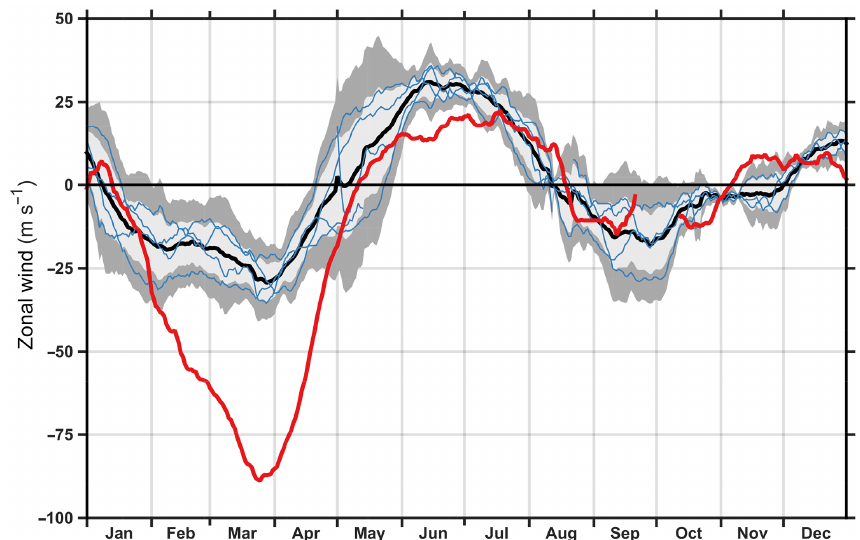
Figure 1. Monthly-mean zonal wind over Ascension Island at a height of 85km altitude during 2002–2007. The thin blue lines are the zonal wind for each of the years 2003–2007, and the mean for this period is shown by the thick black line. The light and dark grey filled areas show 1 and 2 standard deviations from the mean respectively. The thick red line shows the zonal wind for